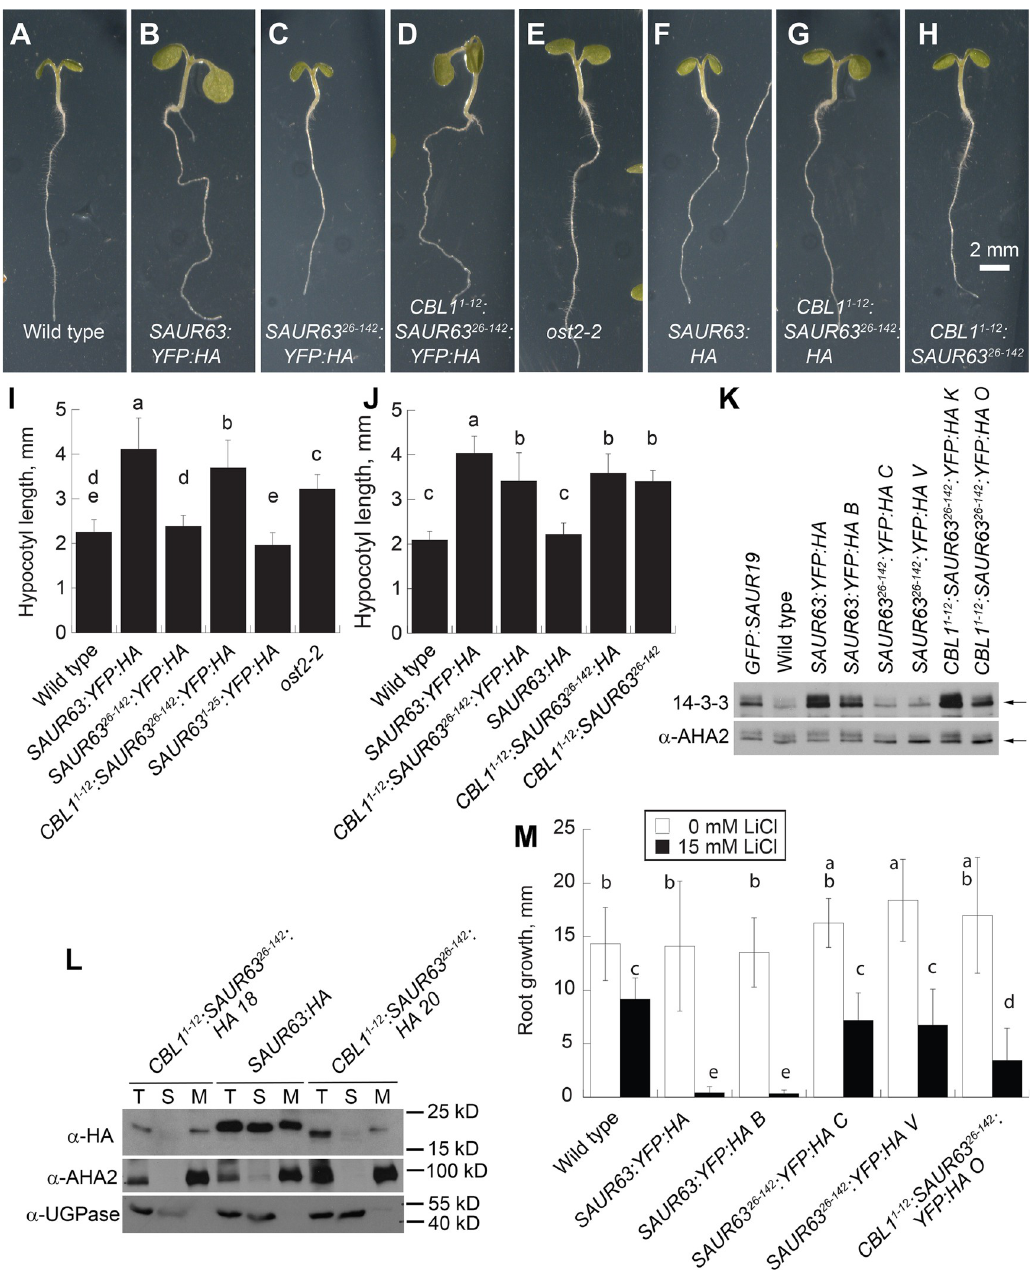
Fig 4. Phenotypic effects of SAUR63 variants with altered N-terminal sequences. A-H) Photographs of 5-day-old seedlings of indicated genotypes. Seedlings were grown in long days in presence of sucrose to allow root growth of all genotypes. Scale bar, 2 mm, is shown in panel H and refers to panels A-H. I,J) Hypocotyl lengths of seedlings of indicated genotypes grown for 4d in short days. K) 14-3-3 overlay western blot of phosphorylated H + -ATPase and western blot of overall AHA2 level from total proteins of seedlings of indicated genotypes. Arrows indicate phosphorylated AHA protein (upper blot) or total AHA protein (lower blot). L) Fractionation of SAUR63:HA and CBL1 1-12 :SAUR63 26-142 :HA fusion proteins. Two different P 35S : CBL1 1-12 : SAUR63 26-142 : HA lines are shown. T, total protein; S, soluble fraction; M, microsomal fraction; α -HA detects SAUR63 fusion protein; α -AHA2 detects a membrane protein; α -UGPase detects a soluble protein. M) Root growth of 5-day-old seedlings grown for 3 days in the absence or presence of 15 mM LiCl. Graphs in I, J, and M show means ± s.d. Letters in graphs indicate statistical classes based on Tukey’s Honestly Significant Difference test. n, from left to right: Panel I: 24, 32, 28, 20, 31, 28; panel J: 23, 22, 24, 26, 19, 25; panel M: 25, 28, 22, 29, 18, 25, 24, 24, 23, 23, 21, 26.